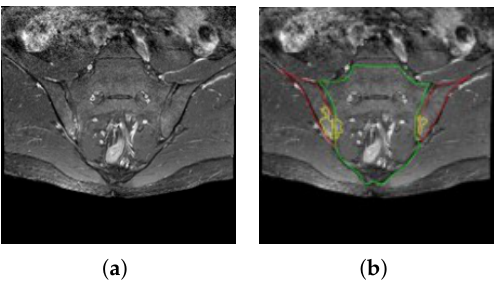
Figure 2. Example MR images of the SIJ region. ( a ) MR images including all areas surrounding the sacral and iliac bones; ( b ) annotated MR images of the sacral (green) and iliac (red) bones as well as bone marrow edema (yellow).